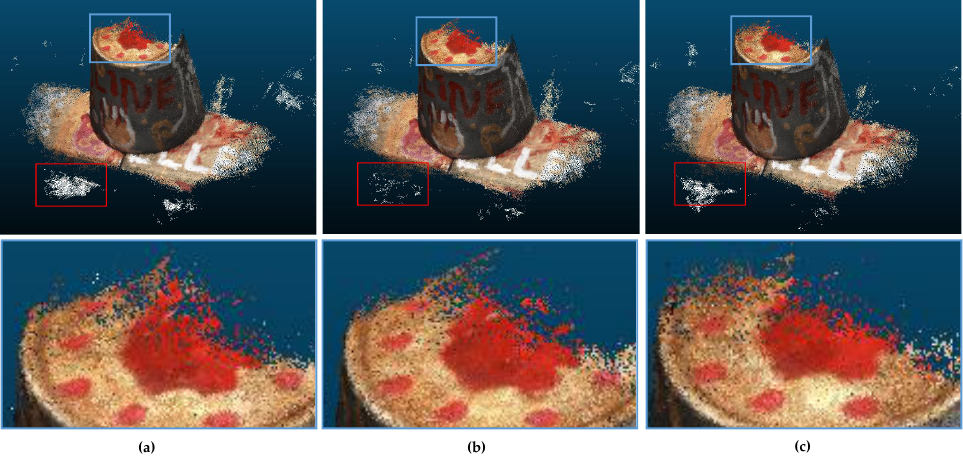
Figure 7. Comparison of reconstructed results. ( a ) Patch size = 2; ( b ) Patch size = 4; ( c ) Patch size = 8.